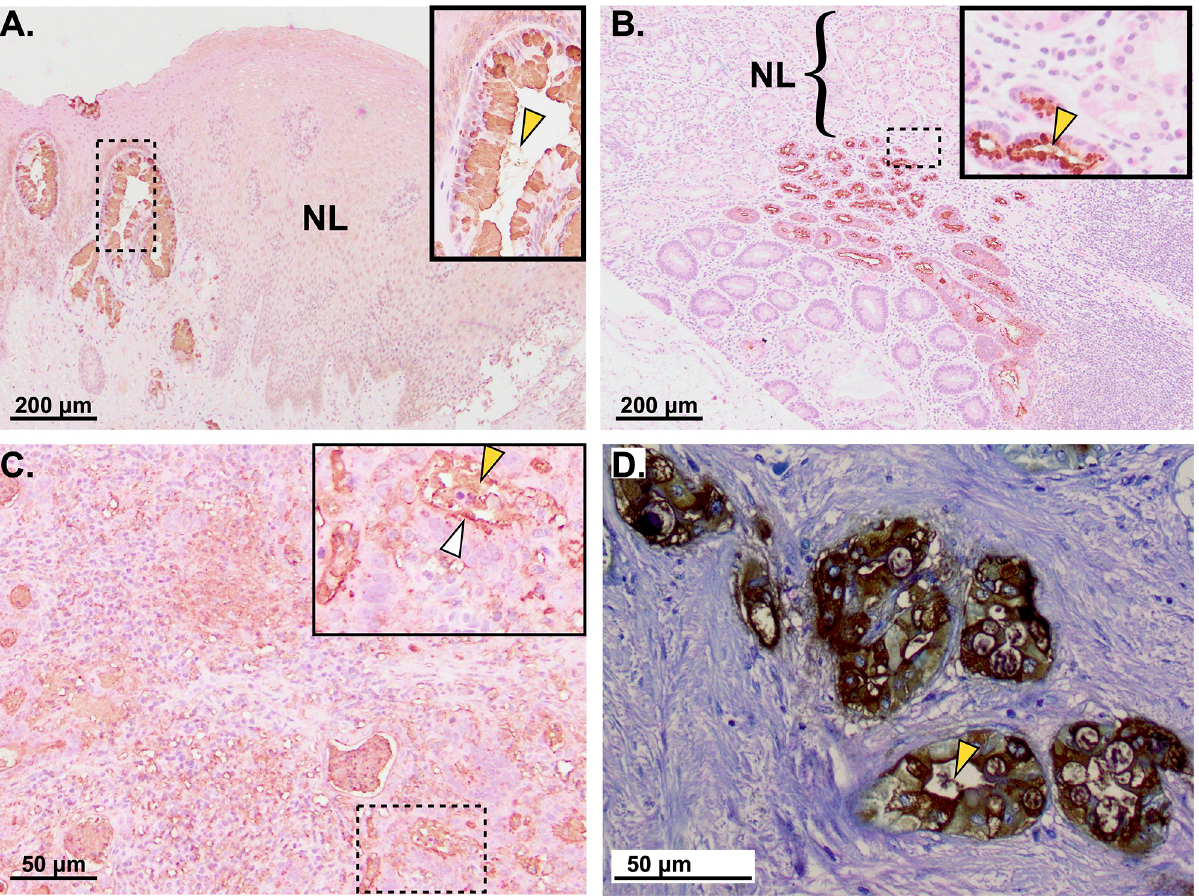
Fig 1. Unlike normal tissue, metaplastically and oncogenically transformed foregut tissues become reactive to mAb Das-1. Immunohistochemistry of A . Barrett’s Esophagus, B . Intestinal Metaplasia of the Stomach (from tissue adjacent to gastric cancer), C . Gastric Cancer, D . Pancreatic Ductal Adenocarcinoma. Scale bars presented in bottom left corner of each panel. Bracket labeled “NL” to highlight the absence of staining in either the esophageal squamous tissue or normal stomach; contrast with incomplete intestinal-type metaplasia, which expresses 3’-Sulfo-Le A . Insets show higher- magnification of boxed areas. White arrowhead: Das-1 staining at a cell apex; yellow arrowhead: 3’-Sulfo-Le A that has been secreted into the extracellular space.